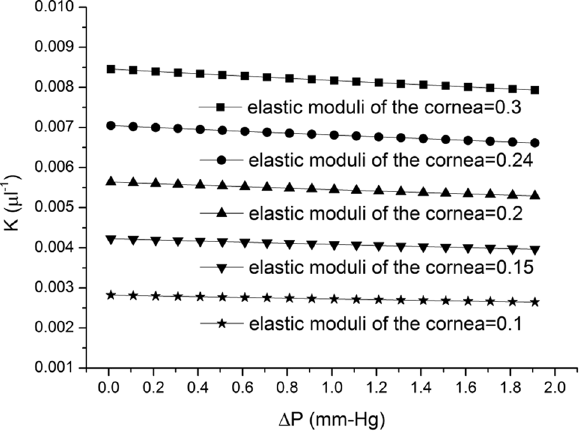
Figure 10. Relationship between IOP changes and K values under different elastic moduli of